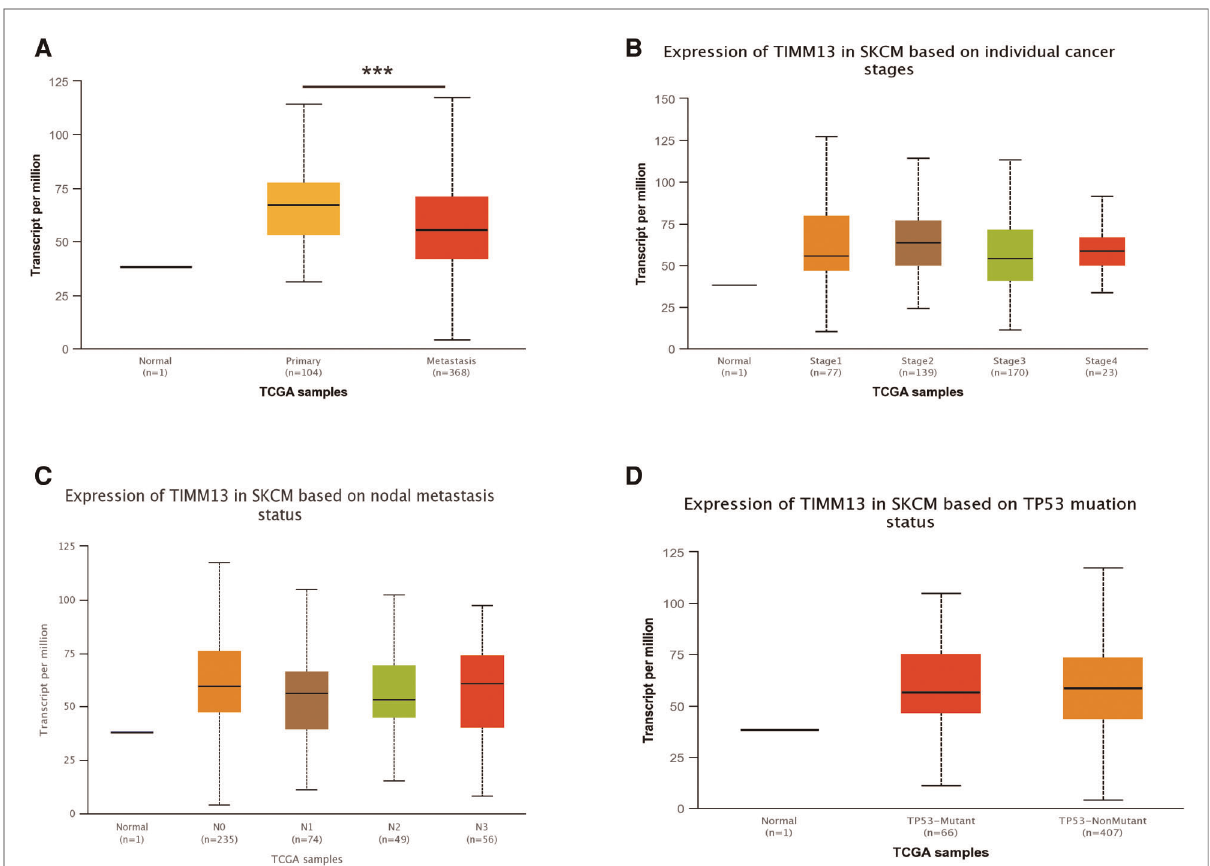
FIGURE 2 Correlation between TIMM13 mRNA expression level and clinicopathological parameters of SKCM through the UALCAN database. ( A ) Sample type (normal/primary tumor). ( B ) Cancer stage (stage 1, 2, 3, and 4). ( C ) Lymph node stage (N0 1, 2, and 3). ( D ) TP53 mutation subgroup. N, normal; P, primary tumor; S1, stage 1; S2, stage 2; S3, stage 3; S4, stage